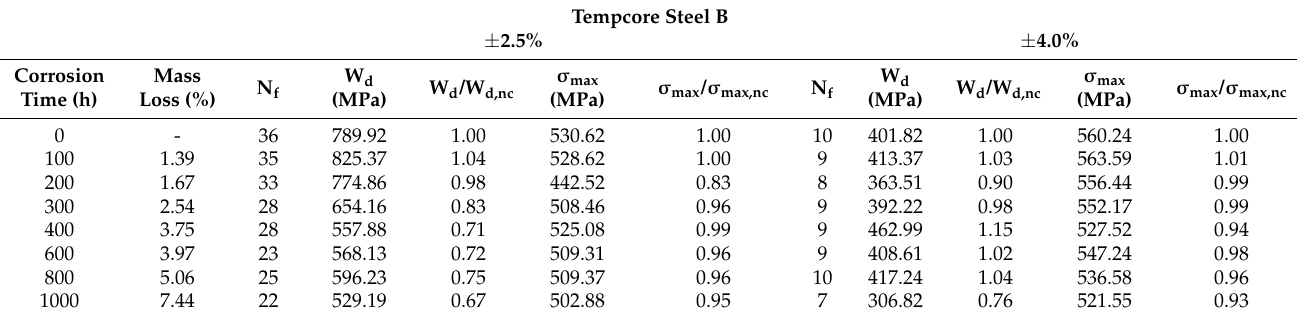
Table 8. Results of LCF tests on Tempcore Steel B (mean